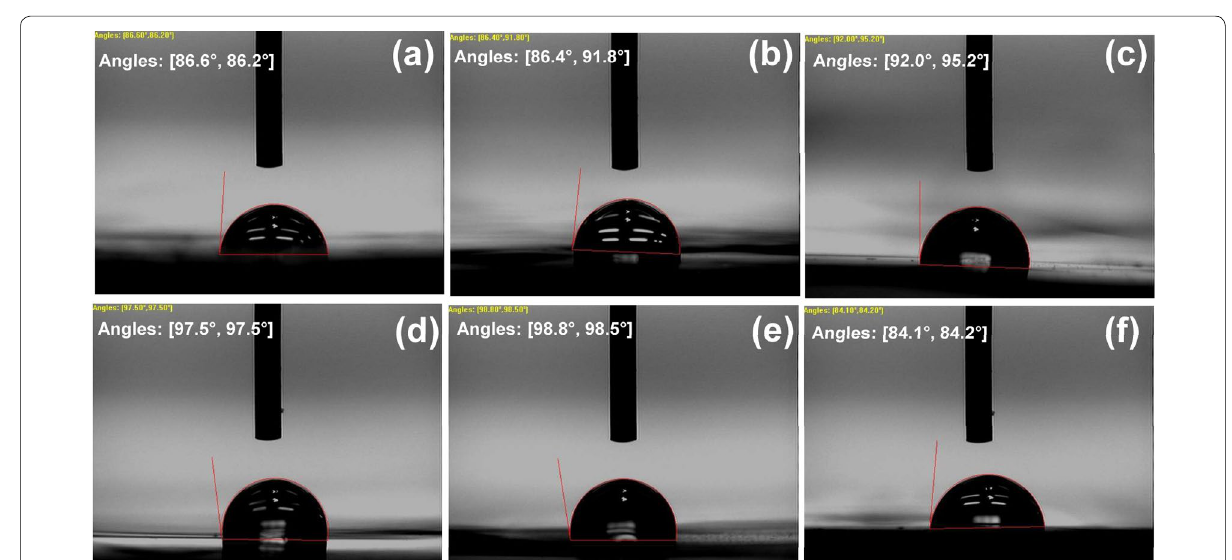
Fig. 6 Images contact angles of water with neat EPR ( a ), GNS/EPR 1 ( b ), GNS/EPR 2 ( c ), GNS/EPR 4 ( d ), GNS/EPR 5 ( e ) and Au NPs/GNS/EPR 5 ( f